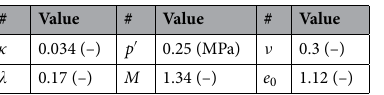
Table 1. Parameters employed for triaxial loading for Boston blue clay 86